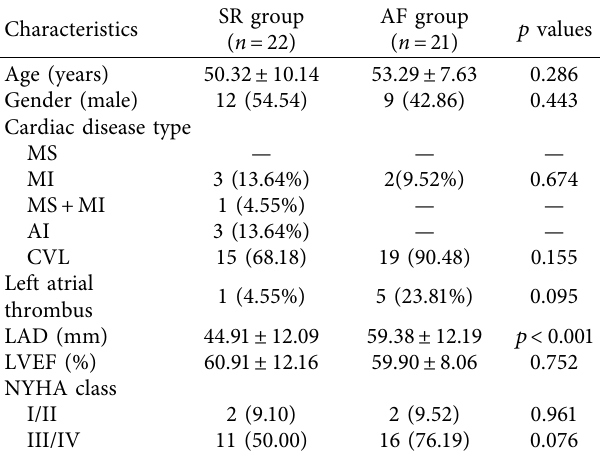
Table 1: The characteristics of patients with SR or AF.